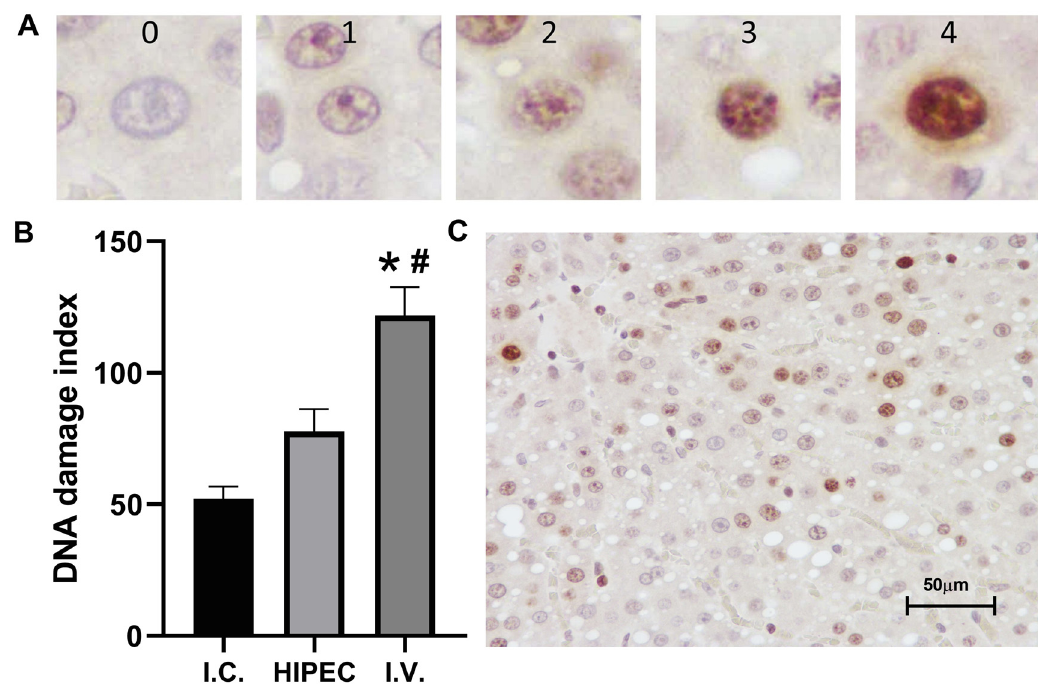
Figure 4. DNA damage in liver tissue (anti-gammaH2AX staining) ( A )—hepatocytes nuclei types/classes ( 0 —no visible staining, 1 —one or several small foci, 2 —more than 3 foci or weak staining of most chromatin, 3 —moderate staining of most or total chromatin, 4 —intense staining), ( B )—DNA damage index, ( C )—representative photomicrograph of liver tissue (i.v. group). *— p < 0.05 compared